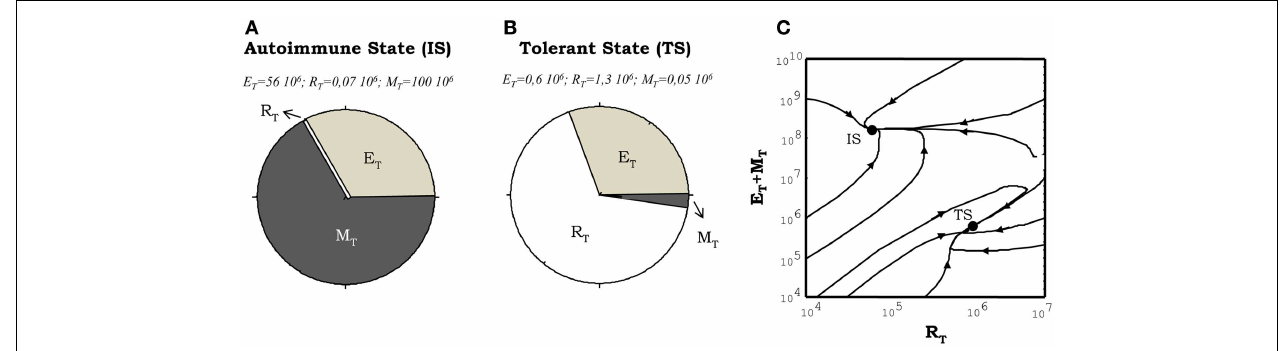
regulatoryT cells dominate the dynamics.The graph in (C) illustrates how these two types of steady state of the system co-exist in the same region of parameter values (the region of bistability). It is shown how different initial conditions, changing just the proportion of E, R, and M cells at time t = 0, leads to trajectories taking the system either in the tolerant (TS) or the autoimmune (IS) steady state.